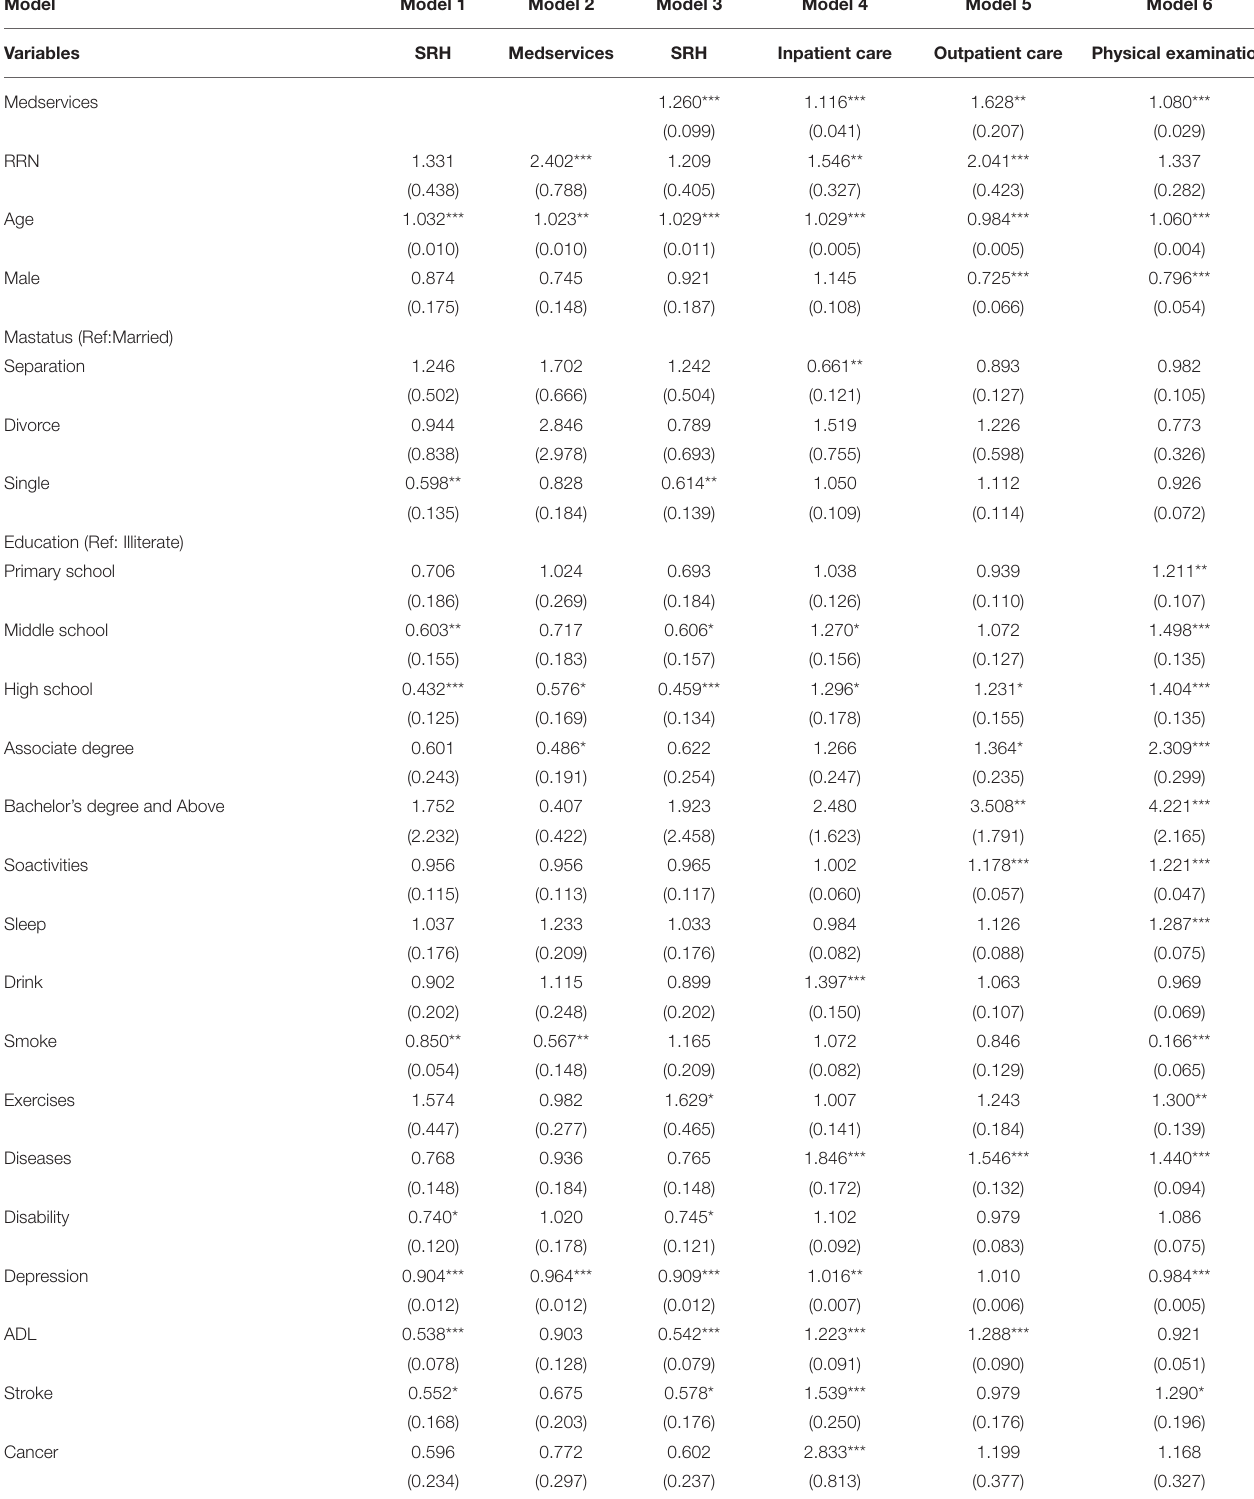
TABLE 3 | The RRN is associated with SRH in rural middle-aged and